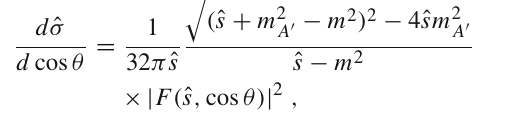
but the DP production in γ e or γ γ collisions have not yet been studied at the ILC, CLIC, or CEPC.